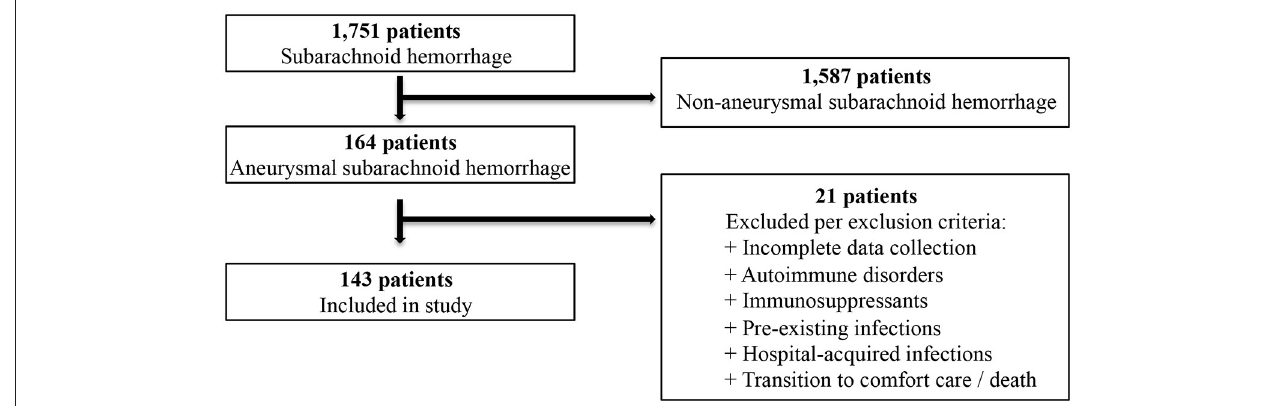
FIGURE 1 | Flow chart depicting the process of patient